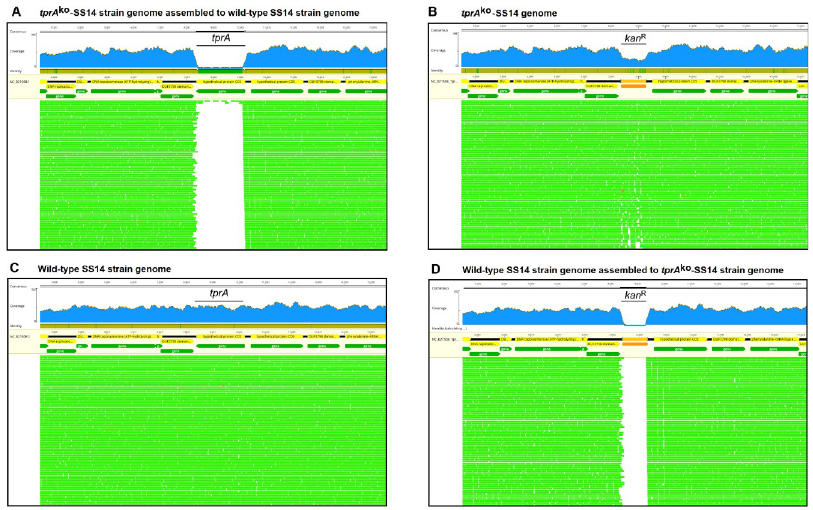
Fig 4. Whole-genome sequencing of DNA template from the tprA ko - and wt-SS14 strain harvested at Passage #9 post-transformation. ( A ) tprA ko -SS14 reads assembled to the wt-SS14 genome sequence (NC_021508.1/CP004011.1) showing a gap where the tprA locus previously was. ( B ) tprA ko -SS14 reads assembled to the wt-SS14 genome sequence where the tprA locus was replaced in silico with the tp0574 promoter- kan R sequence showing reads aligning to the tp0574 promoter- kan R sequence. ( C ) Reads from the wt-SS14 genome (sequenced here as control) aligned to the SS14 reference genome (NC_021508.1/CP004011.1) showing the integrity of the tprA locus. ( D ) Reads from the wt-SS14 genome (sequenced here as control) aligned to the tprA ko -SS14 genome showing a gap where the tp0574 promoter- kan R sequence is